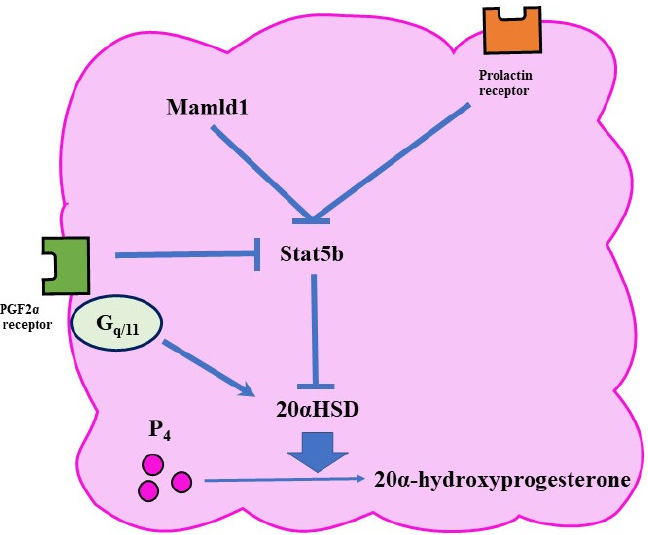
Figure 3. Functional luteolysis. Functional luteolysis is caused by the inactivation of P 4 by 20 α HSD. There are various pathways for regulating the expression of 20 α HSD, such as the FP and prolactin-receptor pathways.